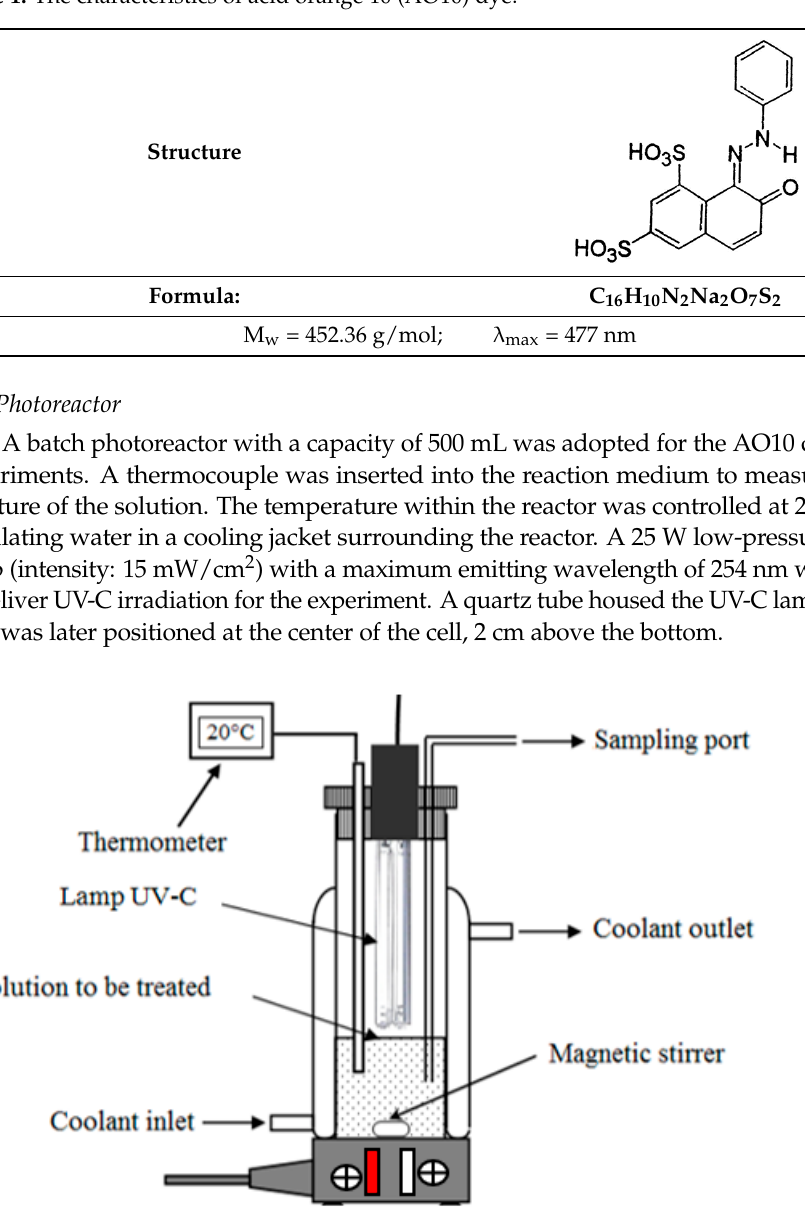
Figure 2. AO10 degradation photoreactor.